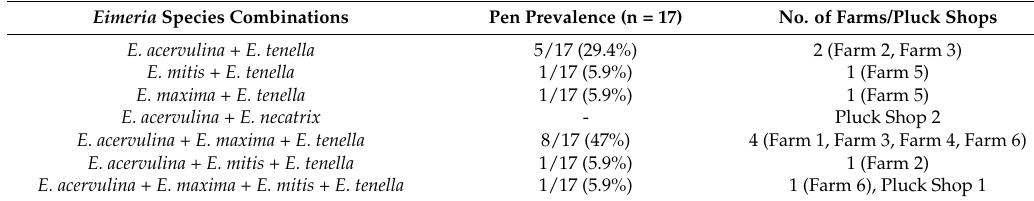
Table 2. Combinations of multiple infections of Eimeria species detected in pens on six broiler farms and two ‘pluck shops’ in Trinidad, West